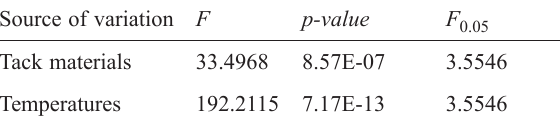
Table 8. ANOVA for field test Source of variation F